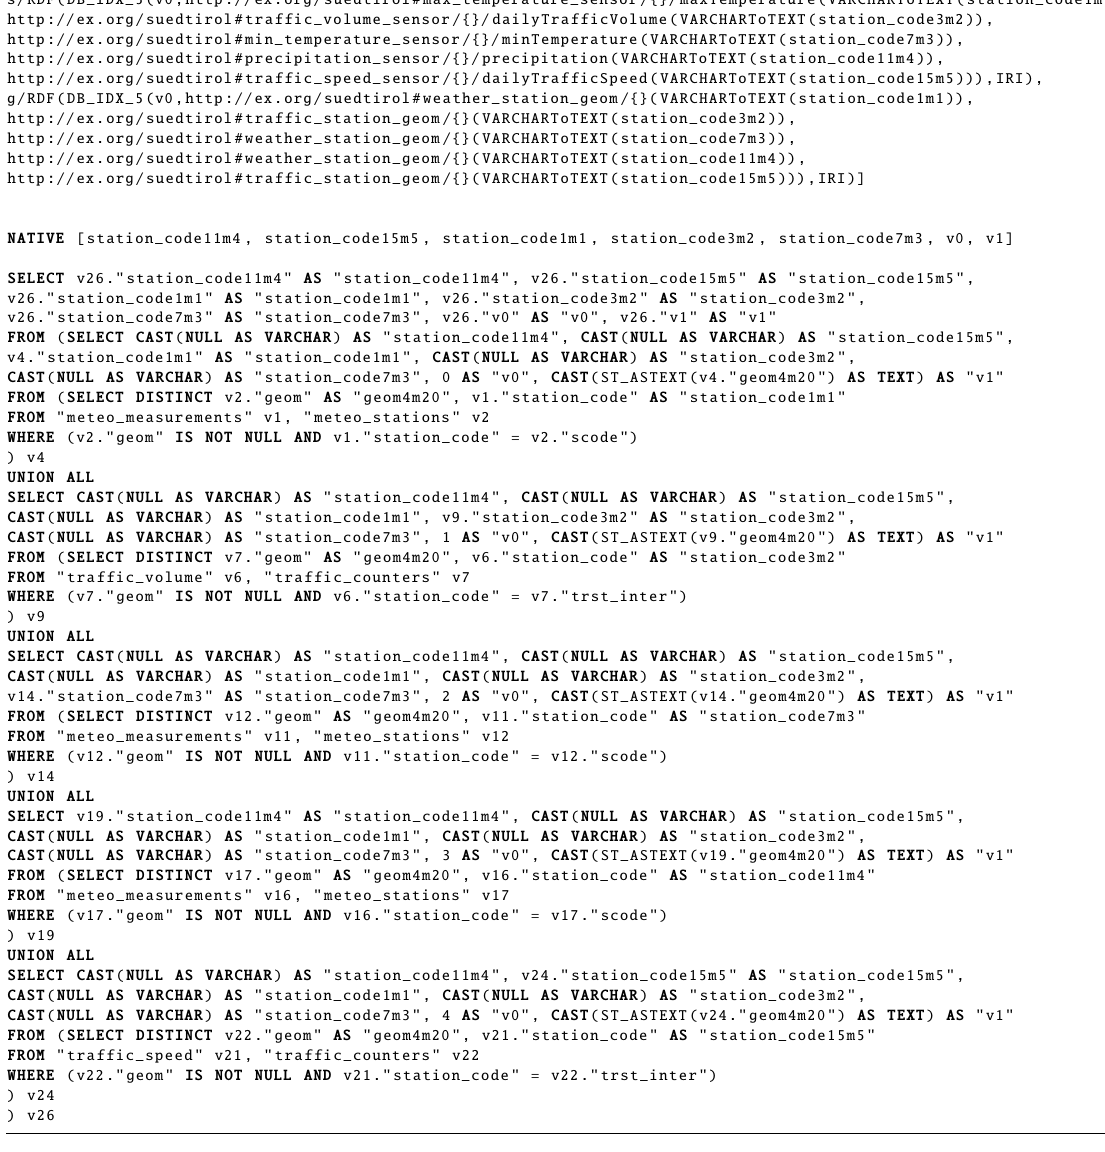
Figure 13. SQL translation of the SPARQL query for Task